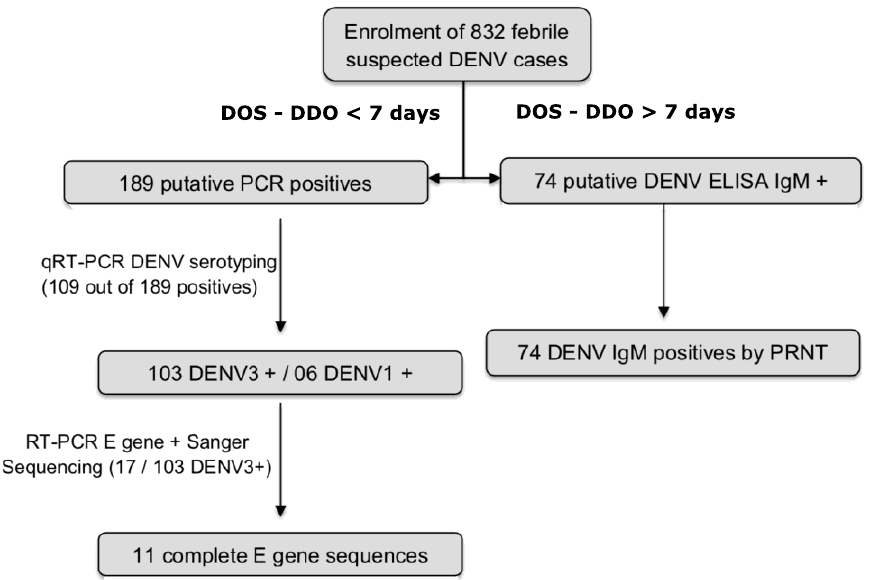
Figure 2. Algorithm of patient enrolment and obtained results. DDO means Date of Disease Onset and DOS means Date of Sampling.